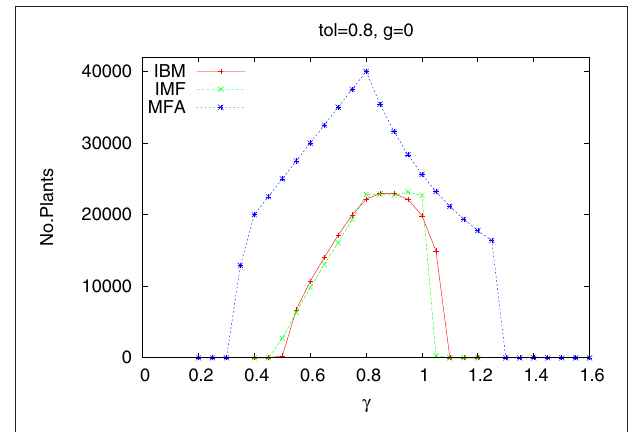
FIGURE 1 | Number of plants as a function of water supply γ . One species. Homogeneous habitat. IBM, IMF, and MFA